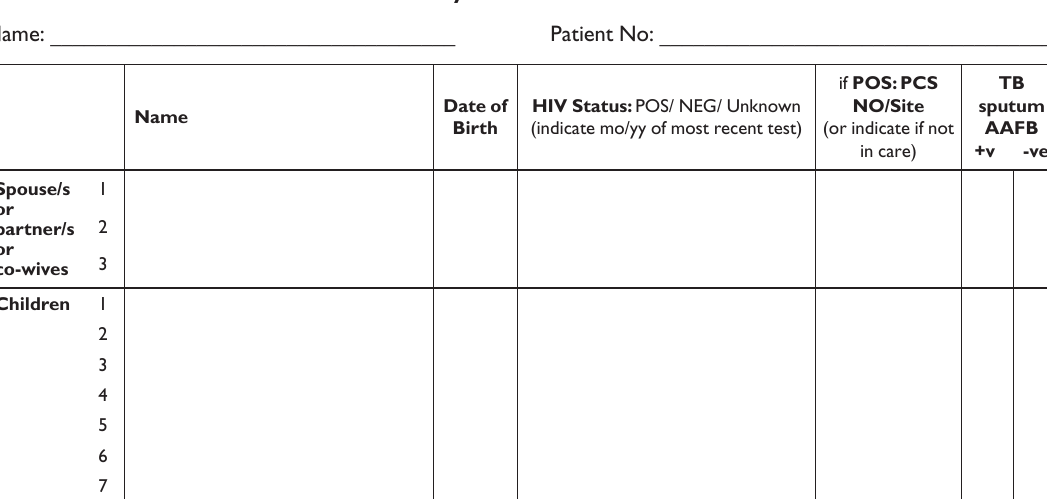
Figure 1 Family Information Table